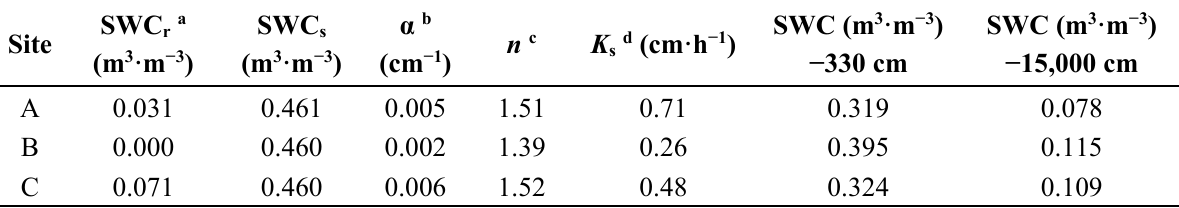
Table 1. Soil hydraulic parameters estimated by means of model inversion using HYDRUS 2D/3D for experimental Sites A, B and